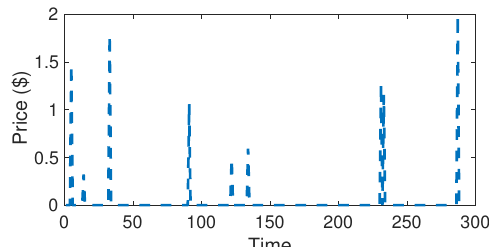
Figure 6. The total penalties ($ per MW) for reactive power across the network at different